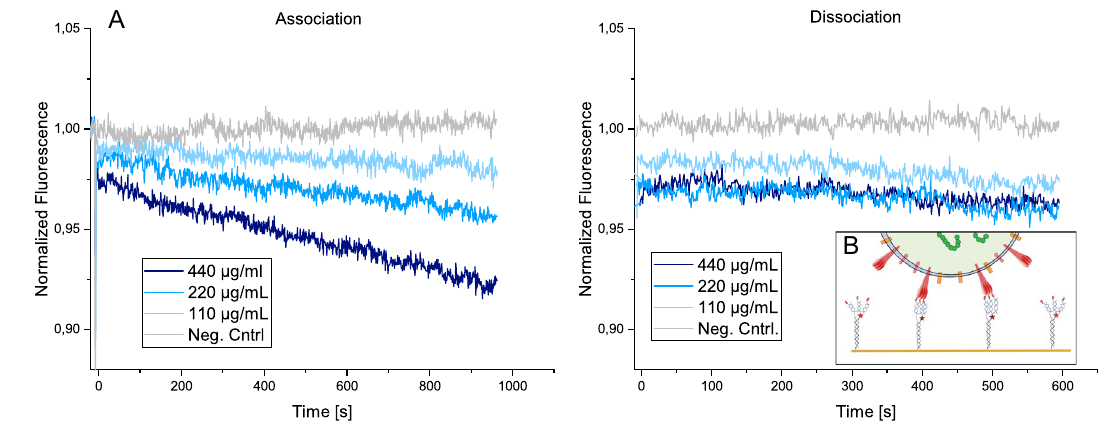
Figure 4. SARS-CoV-2 virus material binding to SBP1-DNA nanostructure. ( A ) Association and dissociation of inactivated SARS-CoV-2 to the DNA nanostructure carrying three SBP1 peptides are presented. The association shows a concentration dependent decrease of the fluorescence intensity signal, indicating a correct binding interaction. The dissociation shows almost no signal change presumably due to multivalent binding interactions. ( B ) Schematic overview of binding process, not drawn to scale.